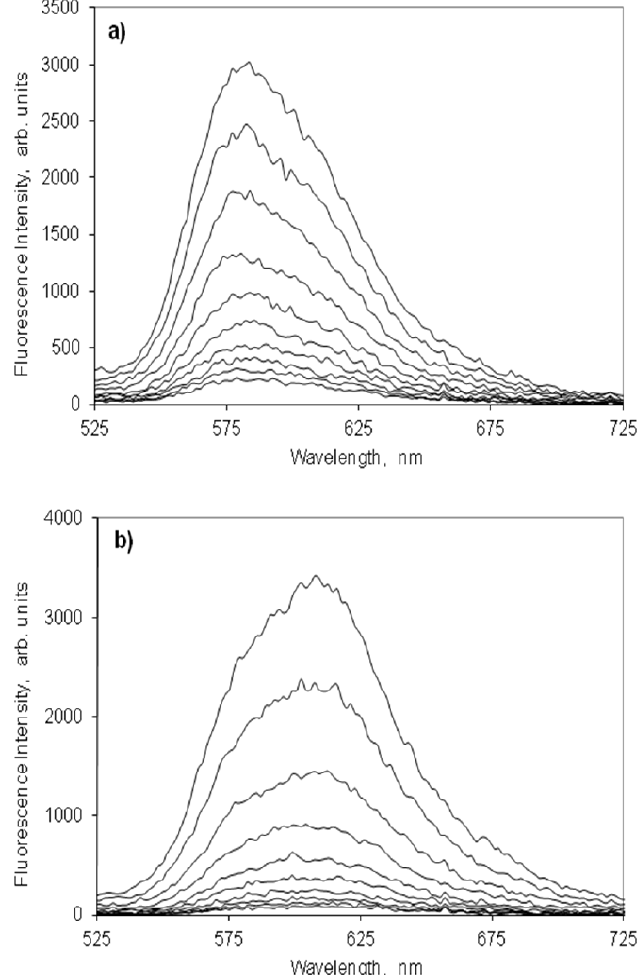
Figure 9. Laser induced time resolved spectra of the 3,3'-di(2-sulfoethyl)-indocarbocyanine dye onto β -cyclodextrin. Curve 1 = 0 ns; Step = 1 ns. Molar ratios are ( a ) 1:1000, ( b ) 1:50 moles of cyanine dye to moles of β -cyclodextrin. The excitation wavelength was 337